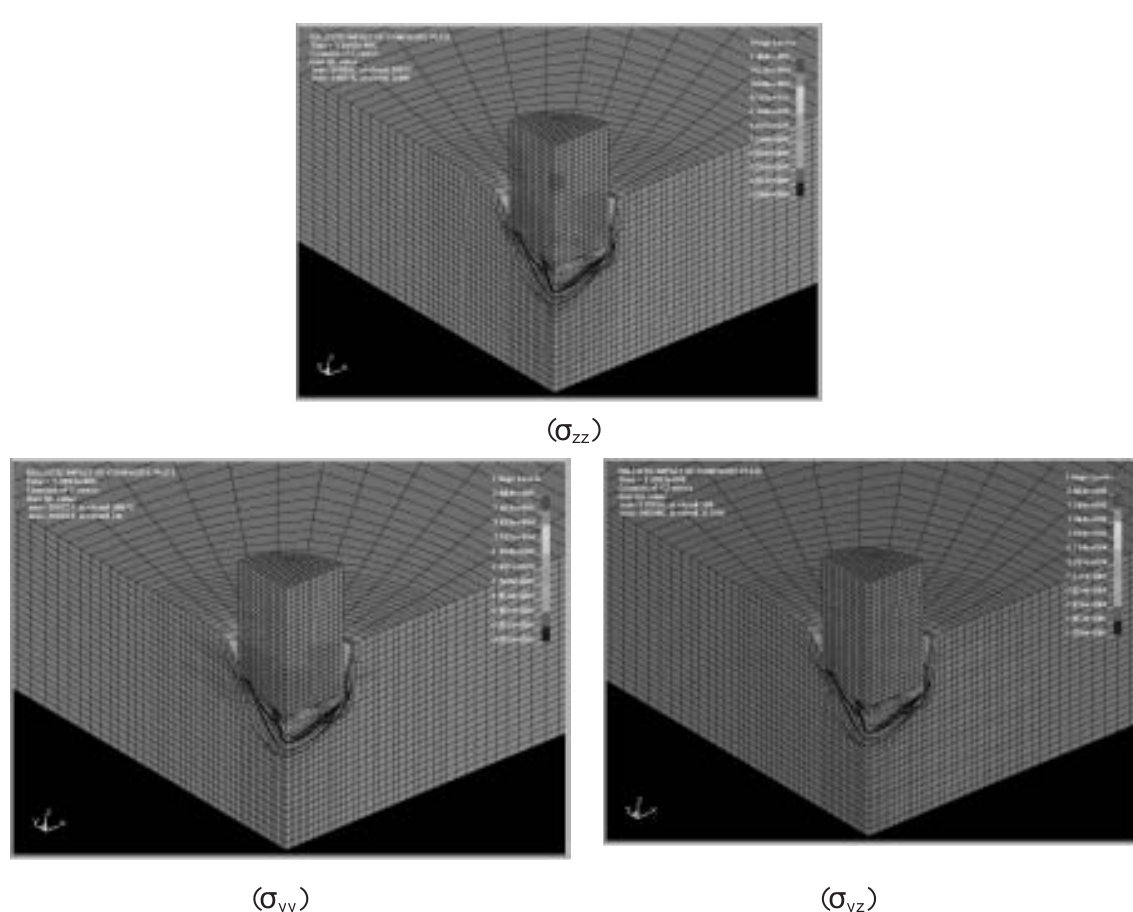
Fig. 10. Deformed shape and stress distribution at t = 1 . 0 E − 05 sec under initial impact velocity V 0 = 508